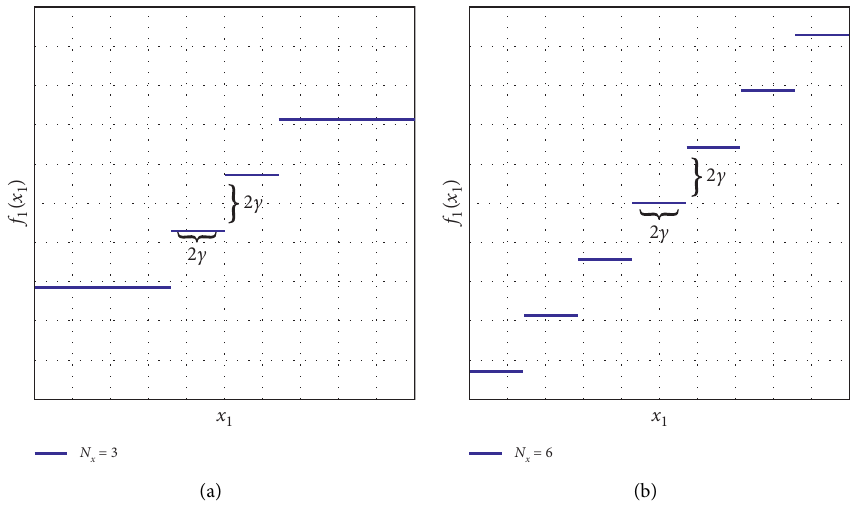
Figure 3: The plot of the function f